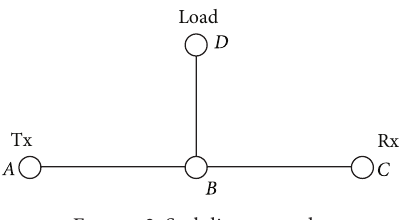
Figure 2: Stub line